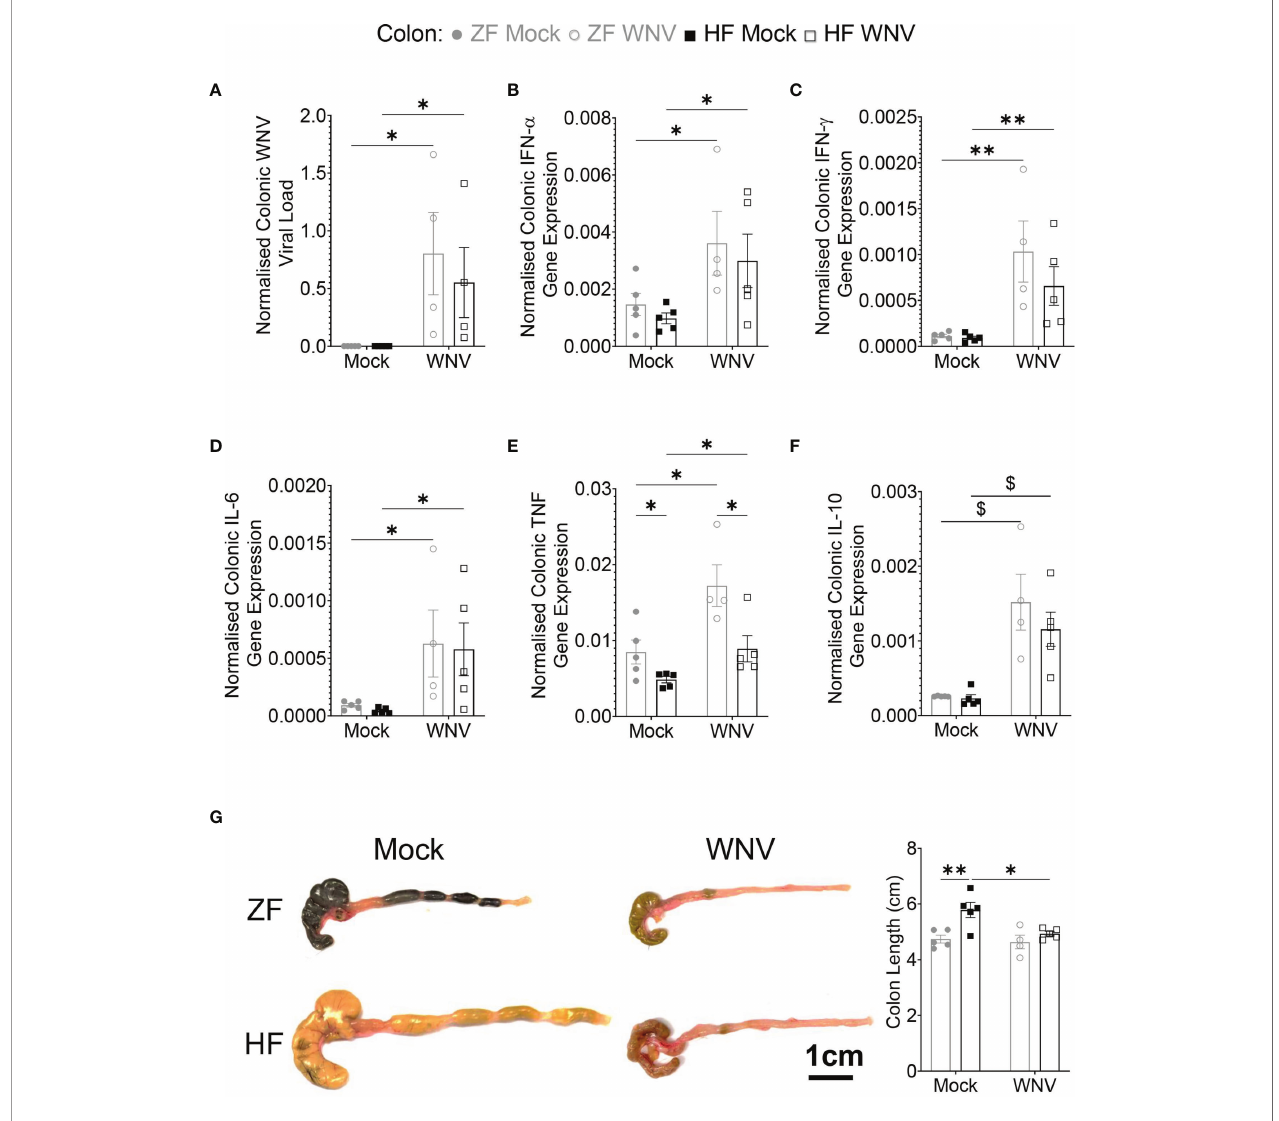
FIGURE 3 | Dietary fi ber did not ameliorate WNV-induced colonic in fl ammation despite reducing TNF. Mice were fed on diets either enriched (HF) or de fi cient (ZF) in dietary fi ber for two weeks and then intranasally infected with LD 100 WNV. WNV viral load (A) , colonic gene expression of Ifna (B) , Ifng (C) , Il6 (D) , Tnf (E) , Il10 (F) was determined by qPCR (n = 4-5 per group). (G) Colon length of mock-infected (Mock) or 7 dpi LD 100 WNV-infected (WNV) mice fed on ZF- or HF-diets were assessed (n = 4-5 per group). Scale bar represents 1cm. Data are represented as mean ± SEM with ∗ p < 0.05; ∗∗ p < 0.01; $ p < 0.001 by two-way